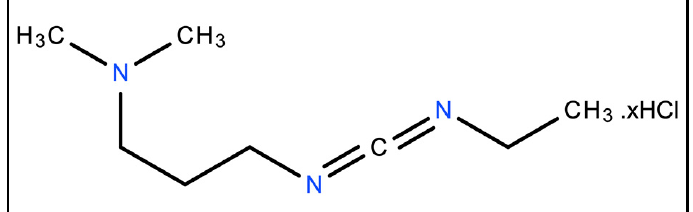
Figure 1. Chemical structure of 1-ethyl-3-[3-dimethylaminopro-pyl]carbodiimide hydrochloride (EDC). Chitosan is a polysaccharide obtained by the deacetylation of chitin, which is widely found in nature. Chitosan has a large number of free carboxyl and amino groups,